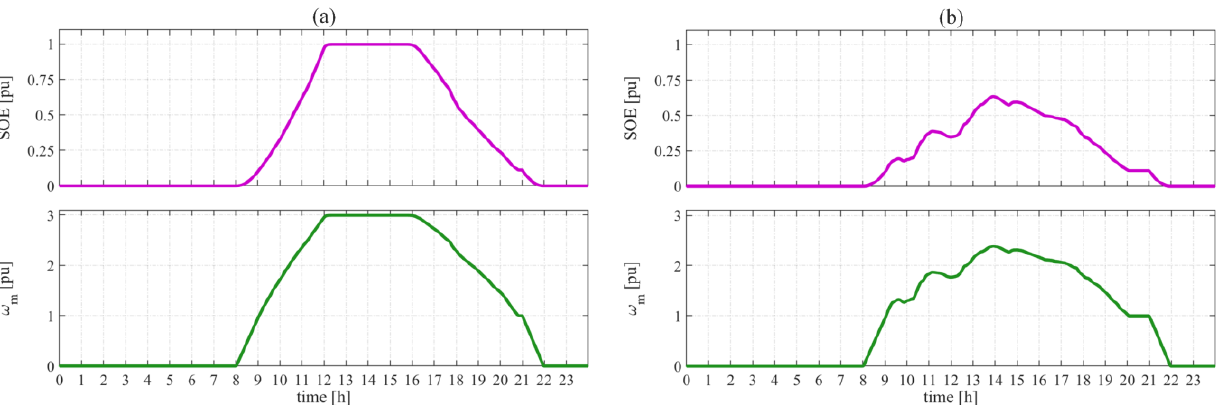
Figure 15. SOE and speed evolutions achieved over a real operating scenario @720 V: cases C1 ( a ) and C2 ( b ).